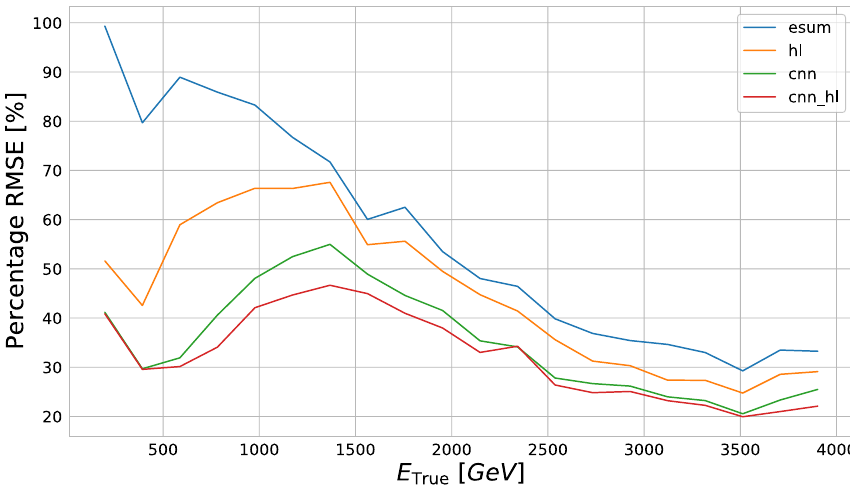
verse E distribution, V[11] – maximum total E in clustered deposits, V[15] – maximum energy of cells excluded from clustered deposits,